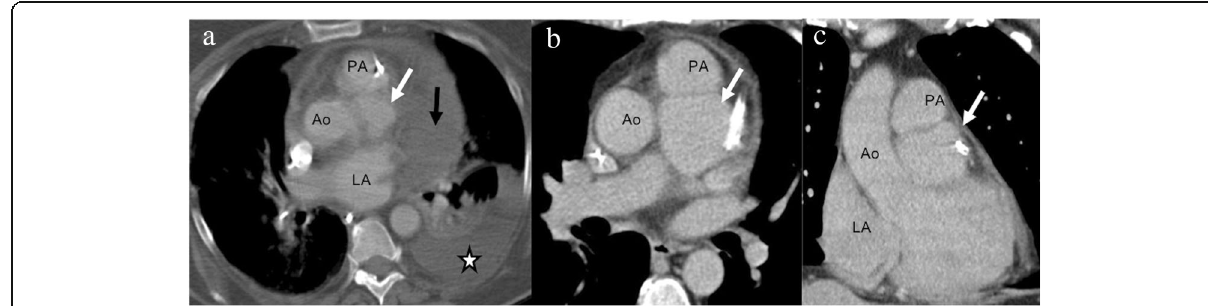
Fig. 7 A 55-year-old female with Staphylococcus aureus sepsis, cardiogenic shock, and pulmonary lesions concerning for septic emboli. Axial ( a ) non-ECG-gated chest CT showed hyperdense purulent pericardial effusion (black arrow in a ) with a contrast filled outpouching at the aortic root (white arrow) and left pleural effusion (star). The contrast outpouching was not recognized by a non-cardiovascular imager. Follow-up axial ( b ) and coronal ( c ) high-pitch CT images (venous phase) after 1 month of treatment showed resolution of pericardial effusion but enlarged pseudoaneurysm (white arrow) exerting mass effect on the left anterior descending coronary stent. Surgical repair of the pseudoaneurysm with coronary artery bypass grafting was performed due to continued chest pain